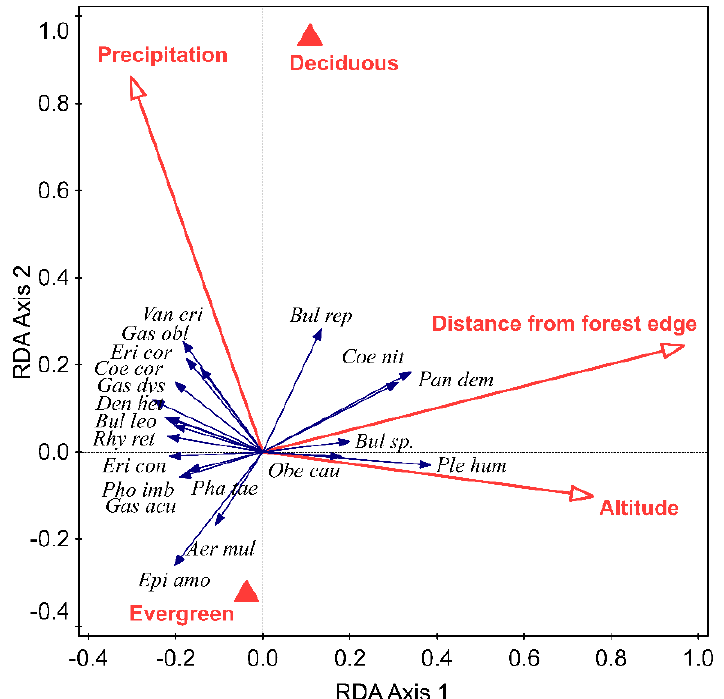
Figure 3. Relationship between different species of orchids and significant environmental variables (indicated by red arrows and red triangles). The 1st redundancy analysis (RDA) axis explained 4.24% and the 2nd 3.11% of the total variation in the data. Names in italics are species and in bold are environmental variables. See Tables S1 and S2 for full names of hosts and orchids.